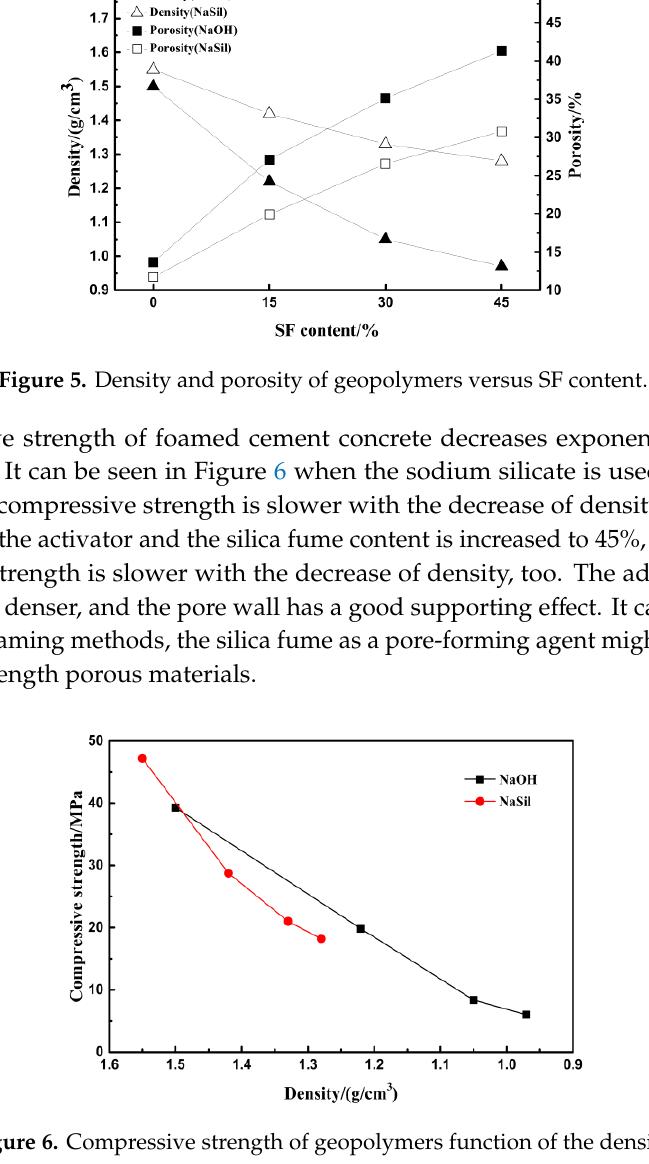
Figure 6. Compressive strength of geopolymers function of the density .